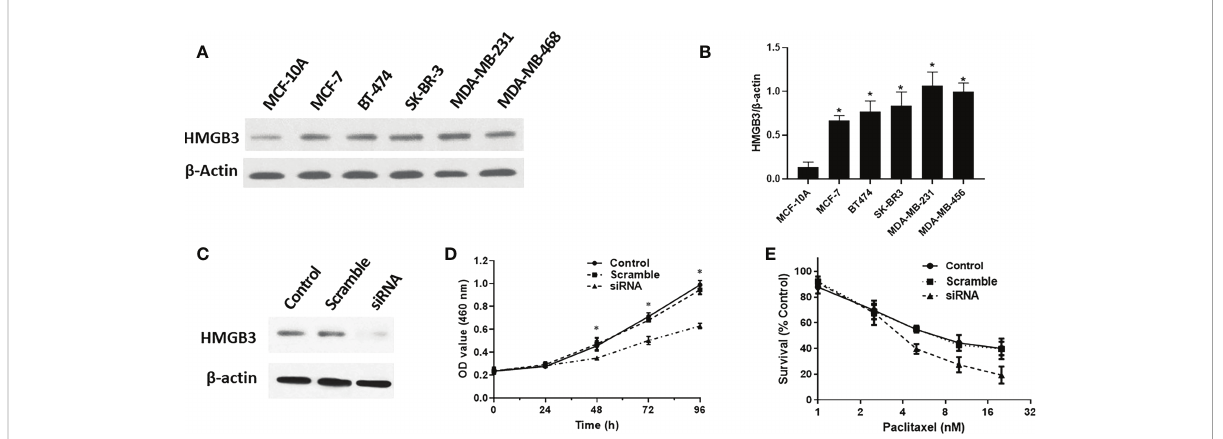
FIGURE 2 HMGB3 expression is correlated with proliferation and drug resistance. (A, B) Expression of HMGB3 in the human breast epithelial cell line MCF- 10A and BC cell line through western blot analysis. (C, D) Cell proliferation was signi fi cantly suppressed in SK-BR-3 breast cancer cells transfected with siRNA. (E) Drug resistance to paclitaxel was reduced after siRNA mediated inhibition of HMGB3 expression. The results are presented as the mean ± SD. * P <